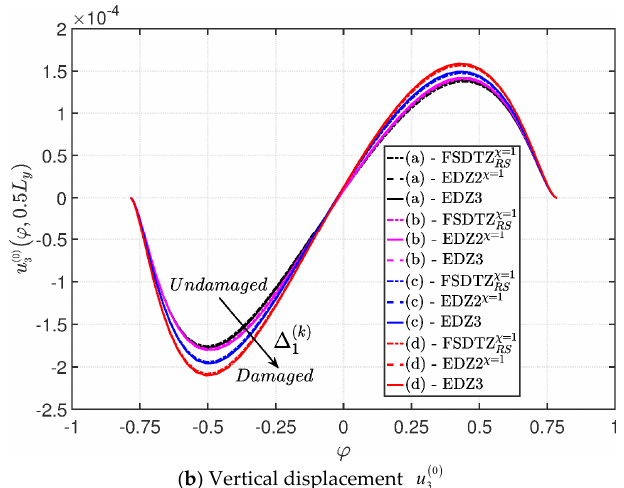
u ; ( 0 ) 1 ; ( b ) Vertical 1 u ; 1